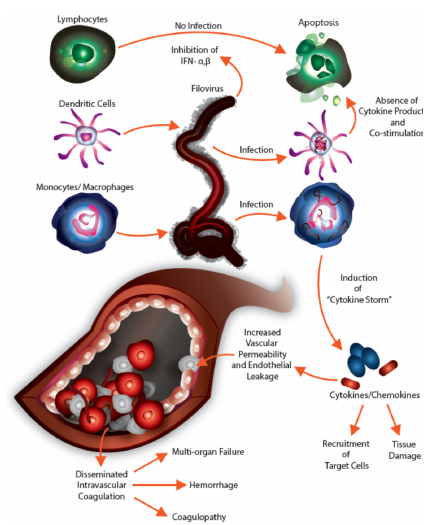
Figure 2. The role of cytokines in filovirus infection and immunopathogenesis.